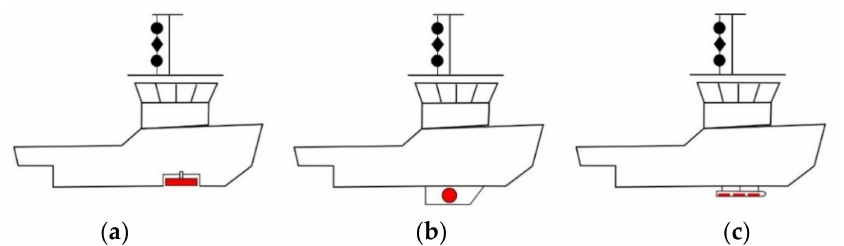
Figure 6. Ways of mounting the MBES transducer to the hull. ( a ) Flush-mount; ( b ) blister installation; ( c ) gondola installation.